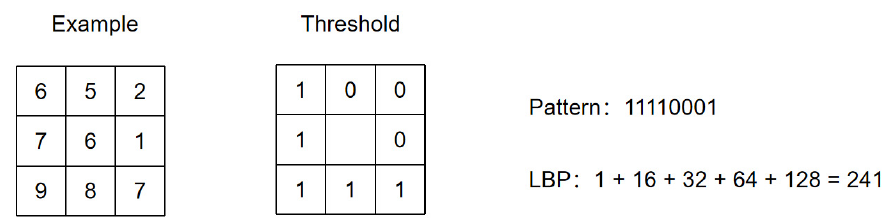
Figure 7. Original LBP